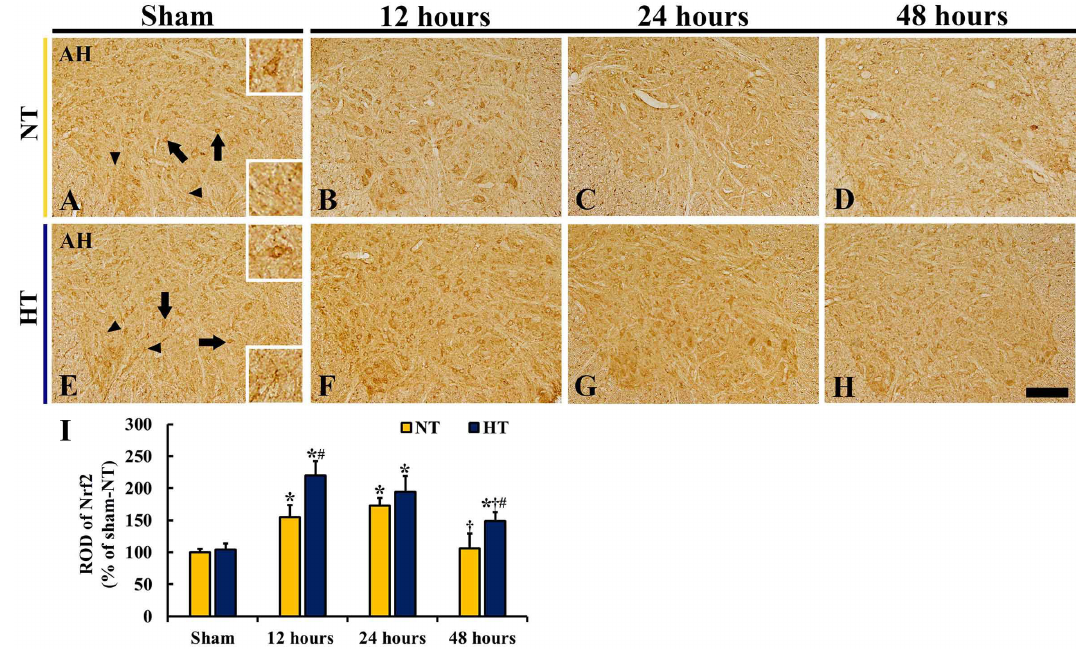
Figure 5. ( A – H ) Nrf2 immunohistochemistry in the anterior horn of the sham-NT ( A ), CA-NT ( B , C ), sham-HT ( E ), and CA-HT ( F – H ) groups at 12 ( B , F ), 24 ( C , G ), and 48 ( D , H ) hours after CA/ROSC. Nrf2 immunoreactivity is shown in the cytoplasm of motor neurons (arrows and upper right box) and glia-like cells (arrowheads and lower right box) in the anterior horn of the sham-NT group. In the CA-NT group, Nrf2 immunoreactivity is increased at 12 h and highest at 24 h. In the CA-HT group, Nrf2 immunoreactivity is higher than in the CA-NT group, showing that the immunoreactivity is highest at 12 h after CA/ROSC. AH, anterior horn. Scale bar = 200 µm. (I) ROD of Nrf2 immunoreactive structures in the anterior horn. The bars indicate the means ± SD ( n = 6, respectively; * p < 0.05 vs. each sham group; † P < 0.05 vs. previous time-point group; # p < 0.05 vs. corresponding CA-NT group).